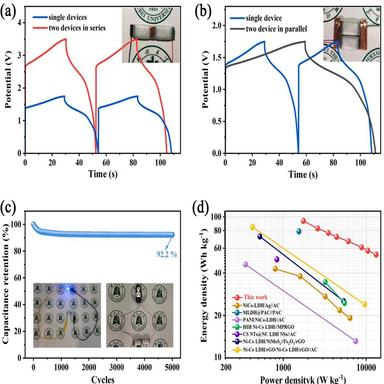
(a, b) GCD comparisons of two ASC devices in series and in parallel with a single device, respectively. Insert is the photographs. (c) Cycling stability of 5000 cycles. Insert is the photographs that two devices in series drive a LED light and electronic watch. (d) Ragone plot (power density vs. energy density).